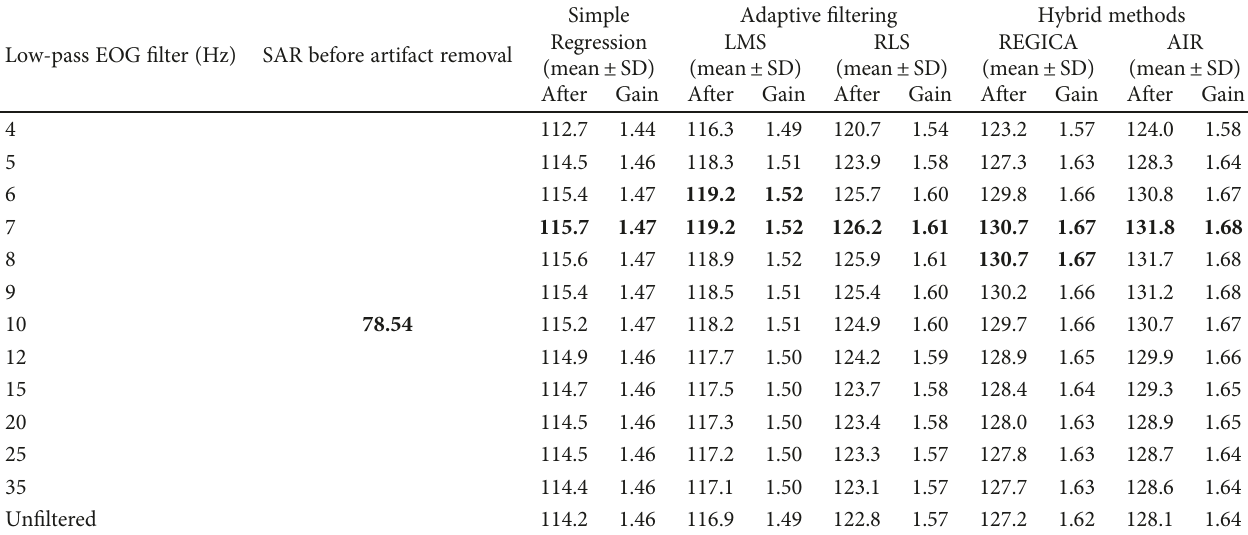
Table 5: Signal-to-artifact ratio for contaminated EEG, corrected EEG, and gain (mean of all EEG channels and mean of all simulated subjects).